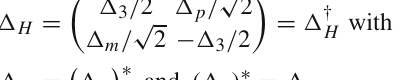
Table 1 Matter contents and their corresponding quantum numbers in G2HDM. New heavy fermions are denoted by the superscript H Matter